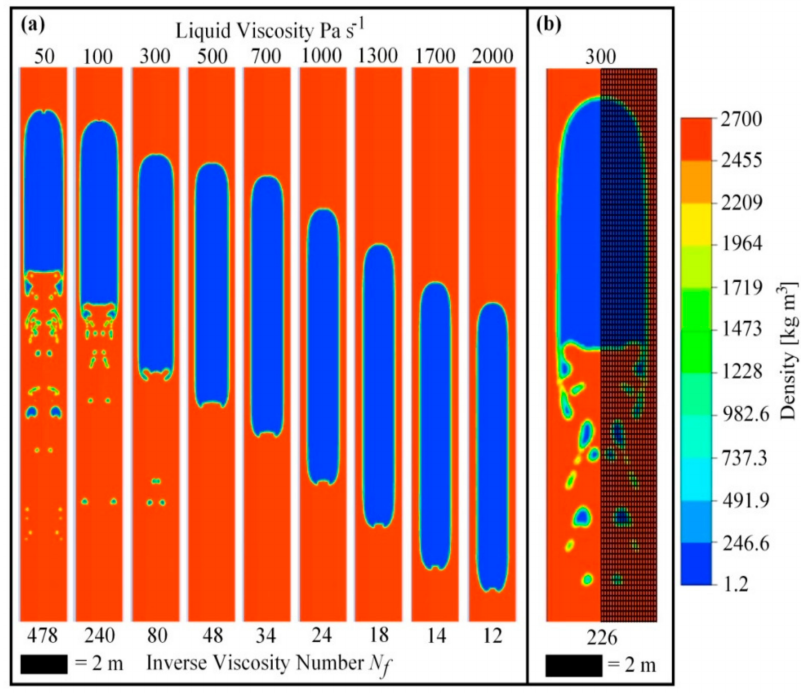
Figure 2. Computational fluid dynamic modeling of rising gas slugs on Stromboli, illustrating the fissuring of daughter bubbles from the slug base. This has been linked to codas in UV camera gas flux time series following strombolian explosions, illustrating the potential of combining models with high time resolution field degassing data to unravel the subterranean drivers of surface activity; ( a ) shows simulations for a range of fluid dynamical conditions e.g., in terms of liquid viscosity and inverse viscosity number, and ( b ) shows a zoom of behaviour for one such parameterisation; see main text and [36] for more